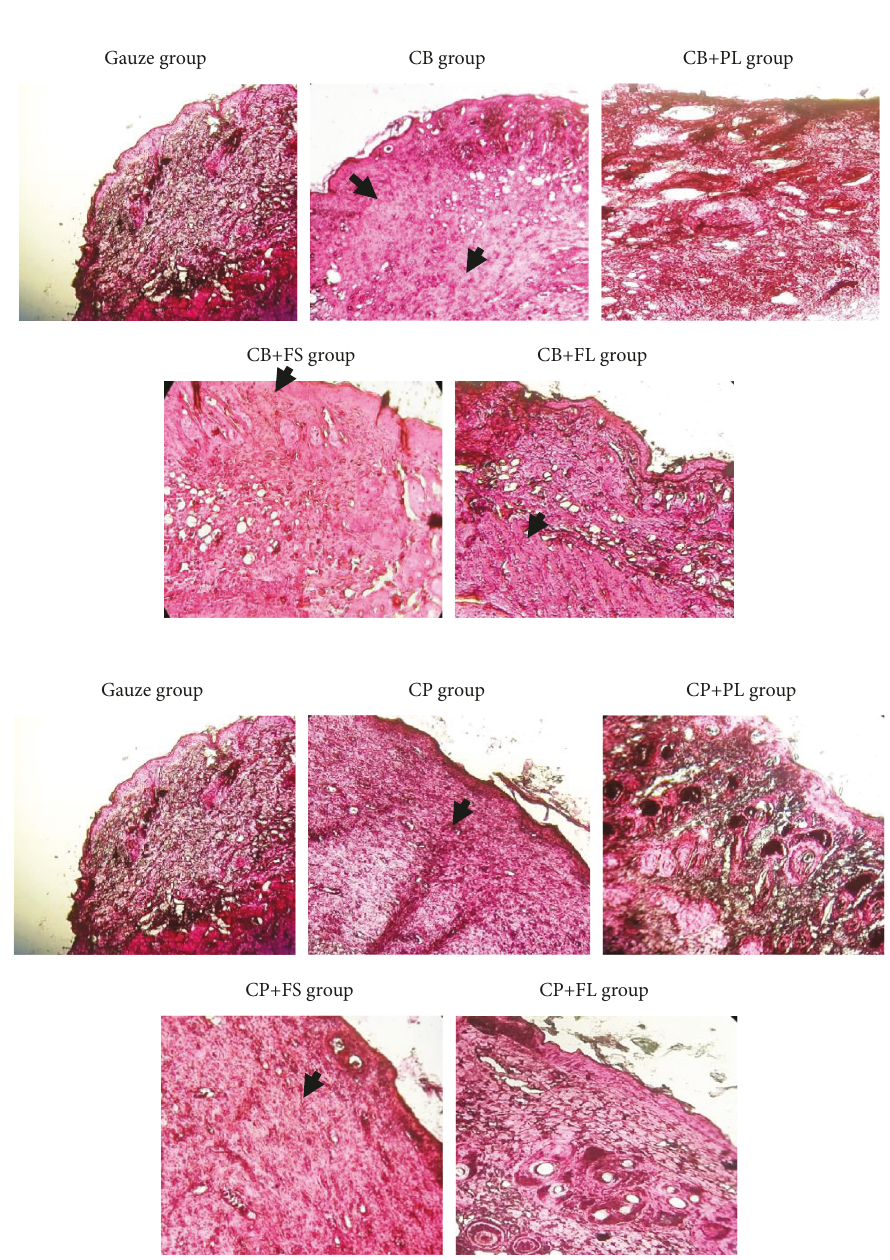
Figure 11: Photomicrographs of histological sections stained in HE representative of the healing wound area in experimental BALB/ c mice on day 15. The gas group (control) shows oedema and fibrinoleukocytic exudate with the presence of numerous inflammatory and mononuclear elements (lymphocytes and plasma cells). Black arrow notes fibrosis. The CP + PL and CP + FL groups show immature, vascular, and oedematous granulation tissue (20 ), while CB + PL and CB + FL show a greater content of proliferative × spindle cells (20 ). For the other groups (CP alone, CP + FS group, CB alone, and CB + FS), the granulation tissue was less vascular and × more cellular (20 ×